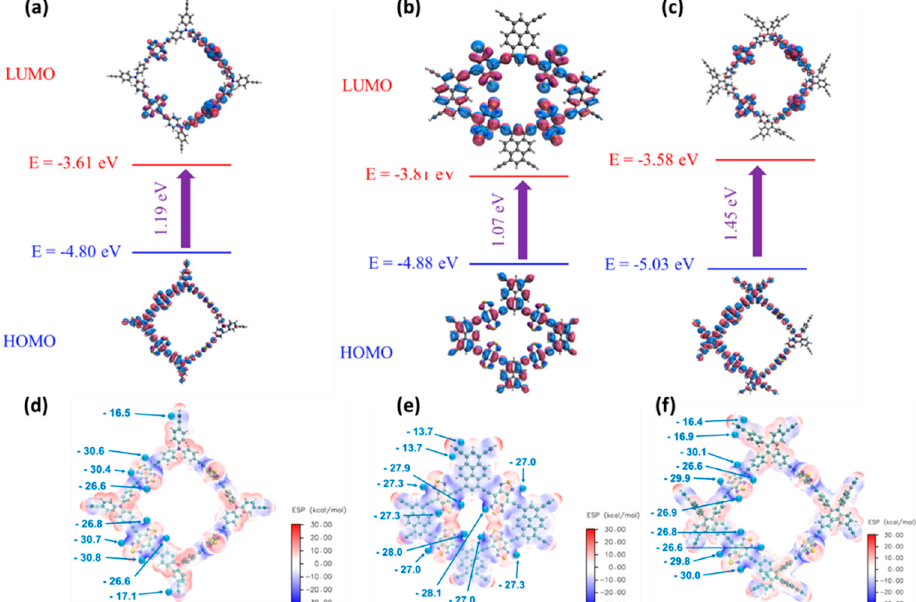
Figure 7. Energy levels and MESP diagrams of the TPA–BBT–CMP ( a , d ), Py–BBT–CMP ( b , e ), and TPE–BBT–CMP ( c , f